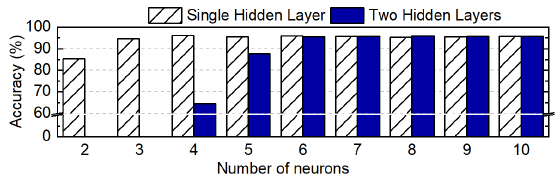
Figure 8. Recognition accuracy according to the number of neurons in the hidden